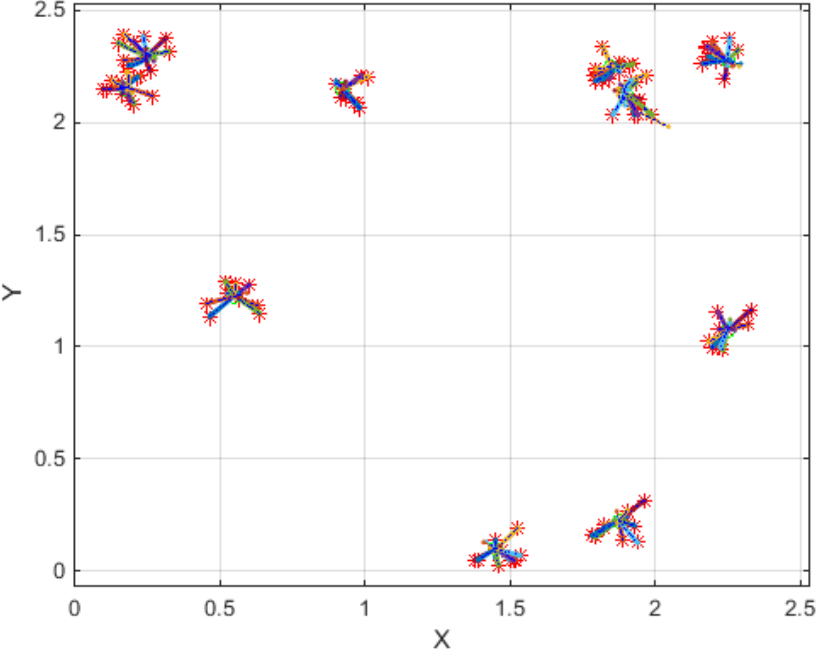
Figure 8. Trajectory of 100 nanoparticles under ten different magnetic field sources (Units of X and Y axes are